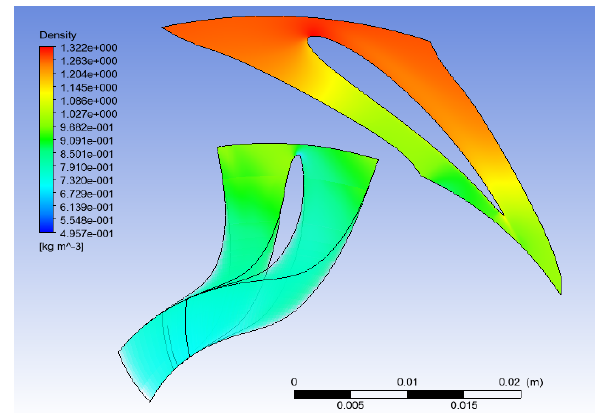
Figure 26. CFD study results: Density